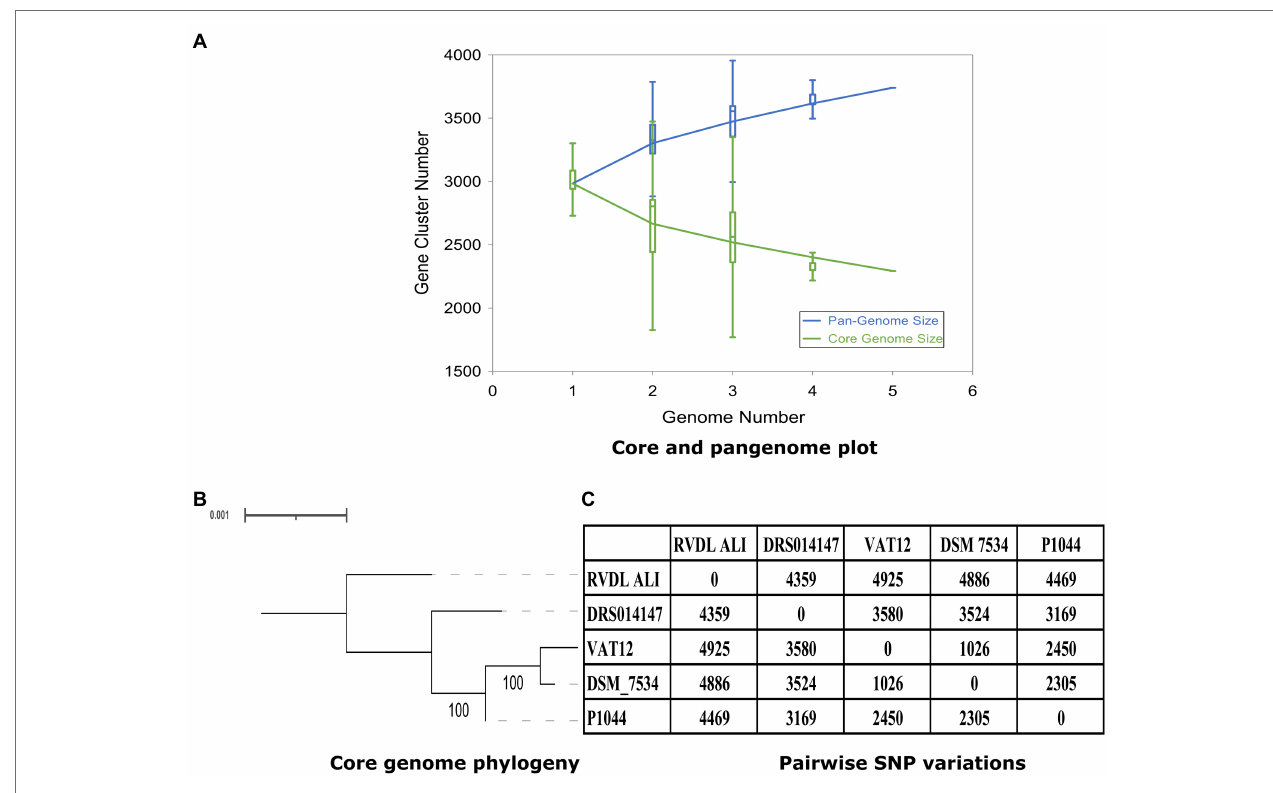
FIGURE 5 | Pangenome, core genome plots and core genome phylogeny. (A) The pan-genome and core genome plot. Pangenome analysis indicated 2,311 and 1,429 core and accessory genes, respectively, and the pangenome profile indicated and open pangenome for C. septicum . (B) Core genome phylogeny based on 2,311 genes. (C) Pairwise SNP variations with in the core genome.